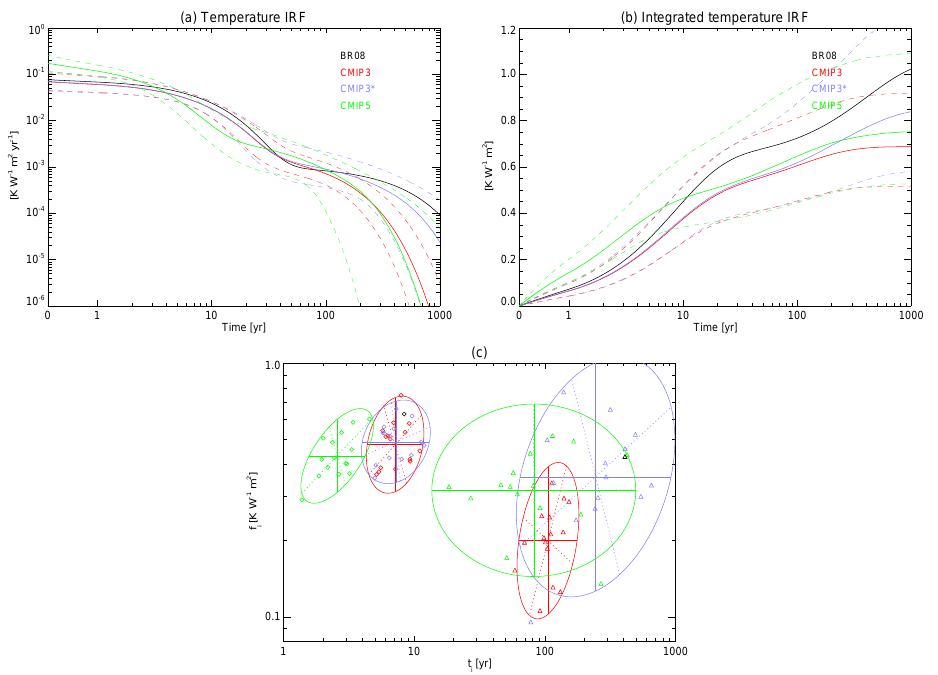
Fig. 2. Overview of four different IRF T distributions: BR08 (black), CMIP3 (red), CMIP3* (blue), and CMIP5 (green). (a) IRF T as in Eq. (5) with median (full line) and 5- and 95-percentile values (dashed lines) indicated. The horizontal axis is linear from 0 to 1yr, and logarithmic from 1 to 1000yr. (b) Integrated IRF T as in Eq. (6). (c) Estimates of the parameters in IRF T . Every single dot corresponds with one of the two modes in a separate AOGCM, i.e. the fast mode (τ 1 ,f 1 ) (diamonds) or the slow mode (τ 2 ,f 2 ) (triangles). The ellipses represent the distributions of the IRF T parameters derived from the individual estimates, grouped per inter-comparison project. Inside the ellipses falls 90% of the distribution.